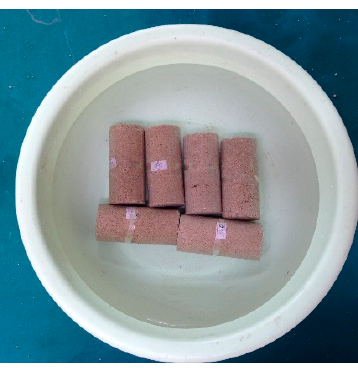
Figure 3. Testing water absorption rate.